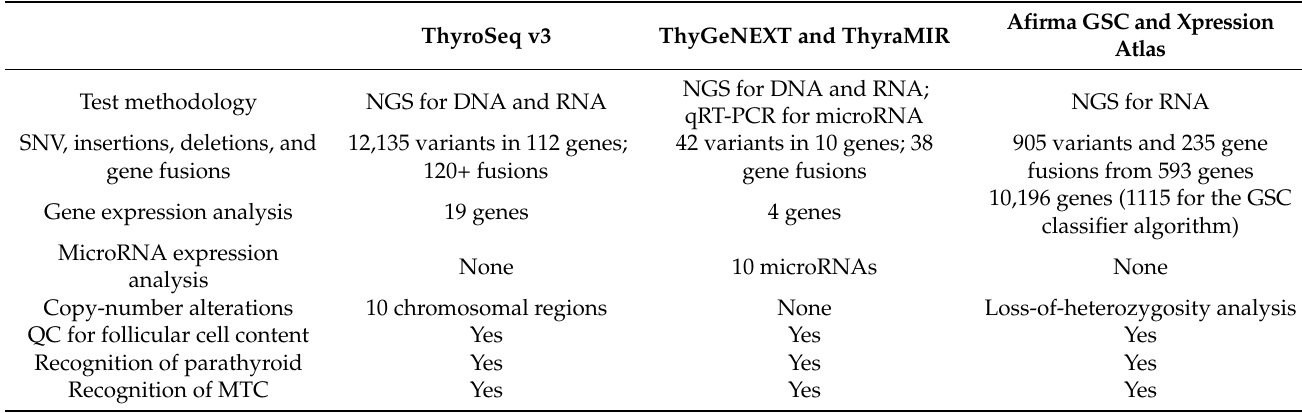
Table 2. Comparison of testing methodology, biomarkers, and quality control measures for the three commercially available thyroid molecular testing platforms in the United States. Afirma GSC and Xpression ThyroSeq v3 ThyGeNEXT and ThyraMIR Atlas NGS for DNA and RNA; NGS for Test methodology NGS for DNA and RNA qRT-PCR for microRNA